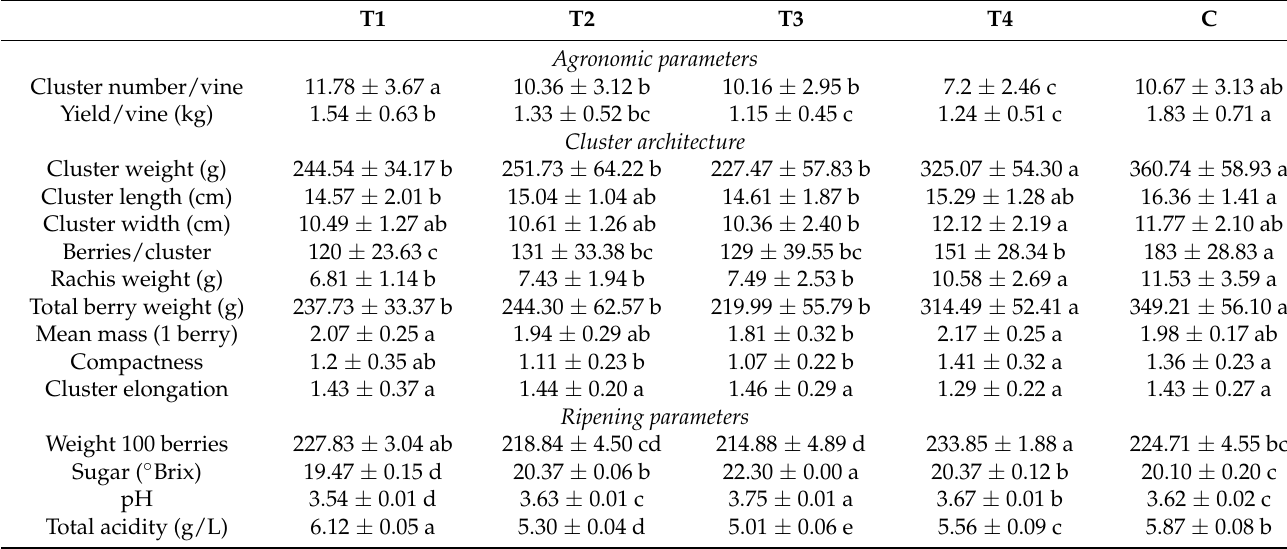
Results are means of 3 repetitions ± S.D. Means within a row designated by different letters are significantly different by the LSD test at p ≤